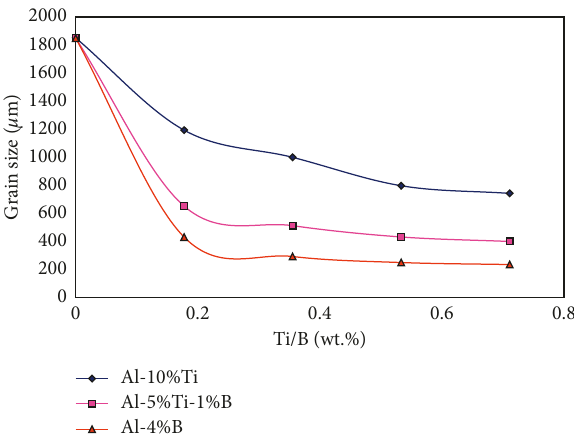
Figure 17: Comparison of the grain size observed in A356.2 alloy as a function of the type of the grain refiner